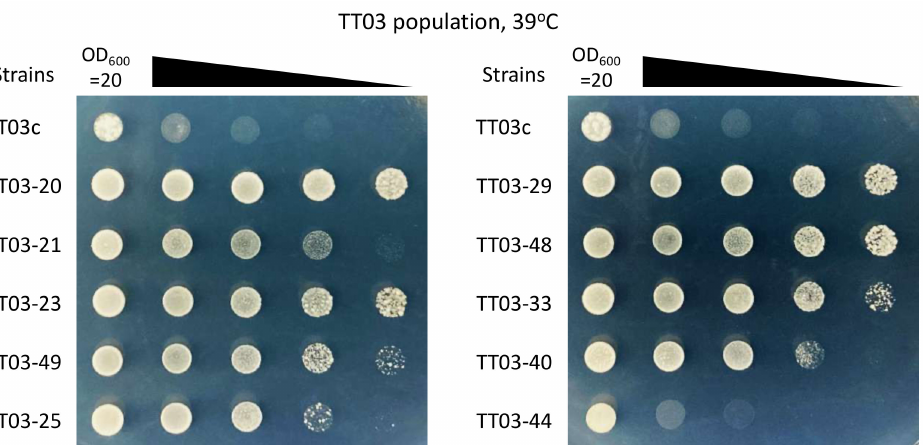
Figure 2. Heat tolerance of reconstructed strains. The dilution series was employed to confirm differences in heat tolerance. Samples were withdrawn from cultures, and their OD 600 values were adjusted to 20. Five-fold serial dilutions of these cultures were prepared in sterile distilled water, and 6 µ L each of the cultures at OD 600 = 20 and their dilutions were spotted onto SD plates without tryptophan. The plates were then incubated at 39 ◦ C for 5 days and